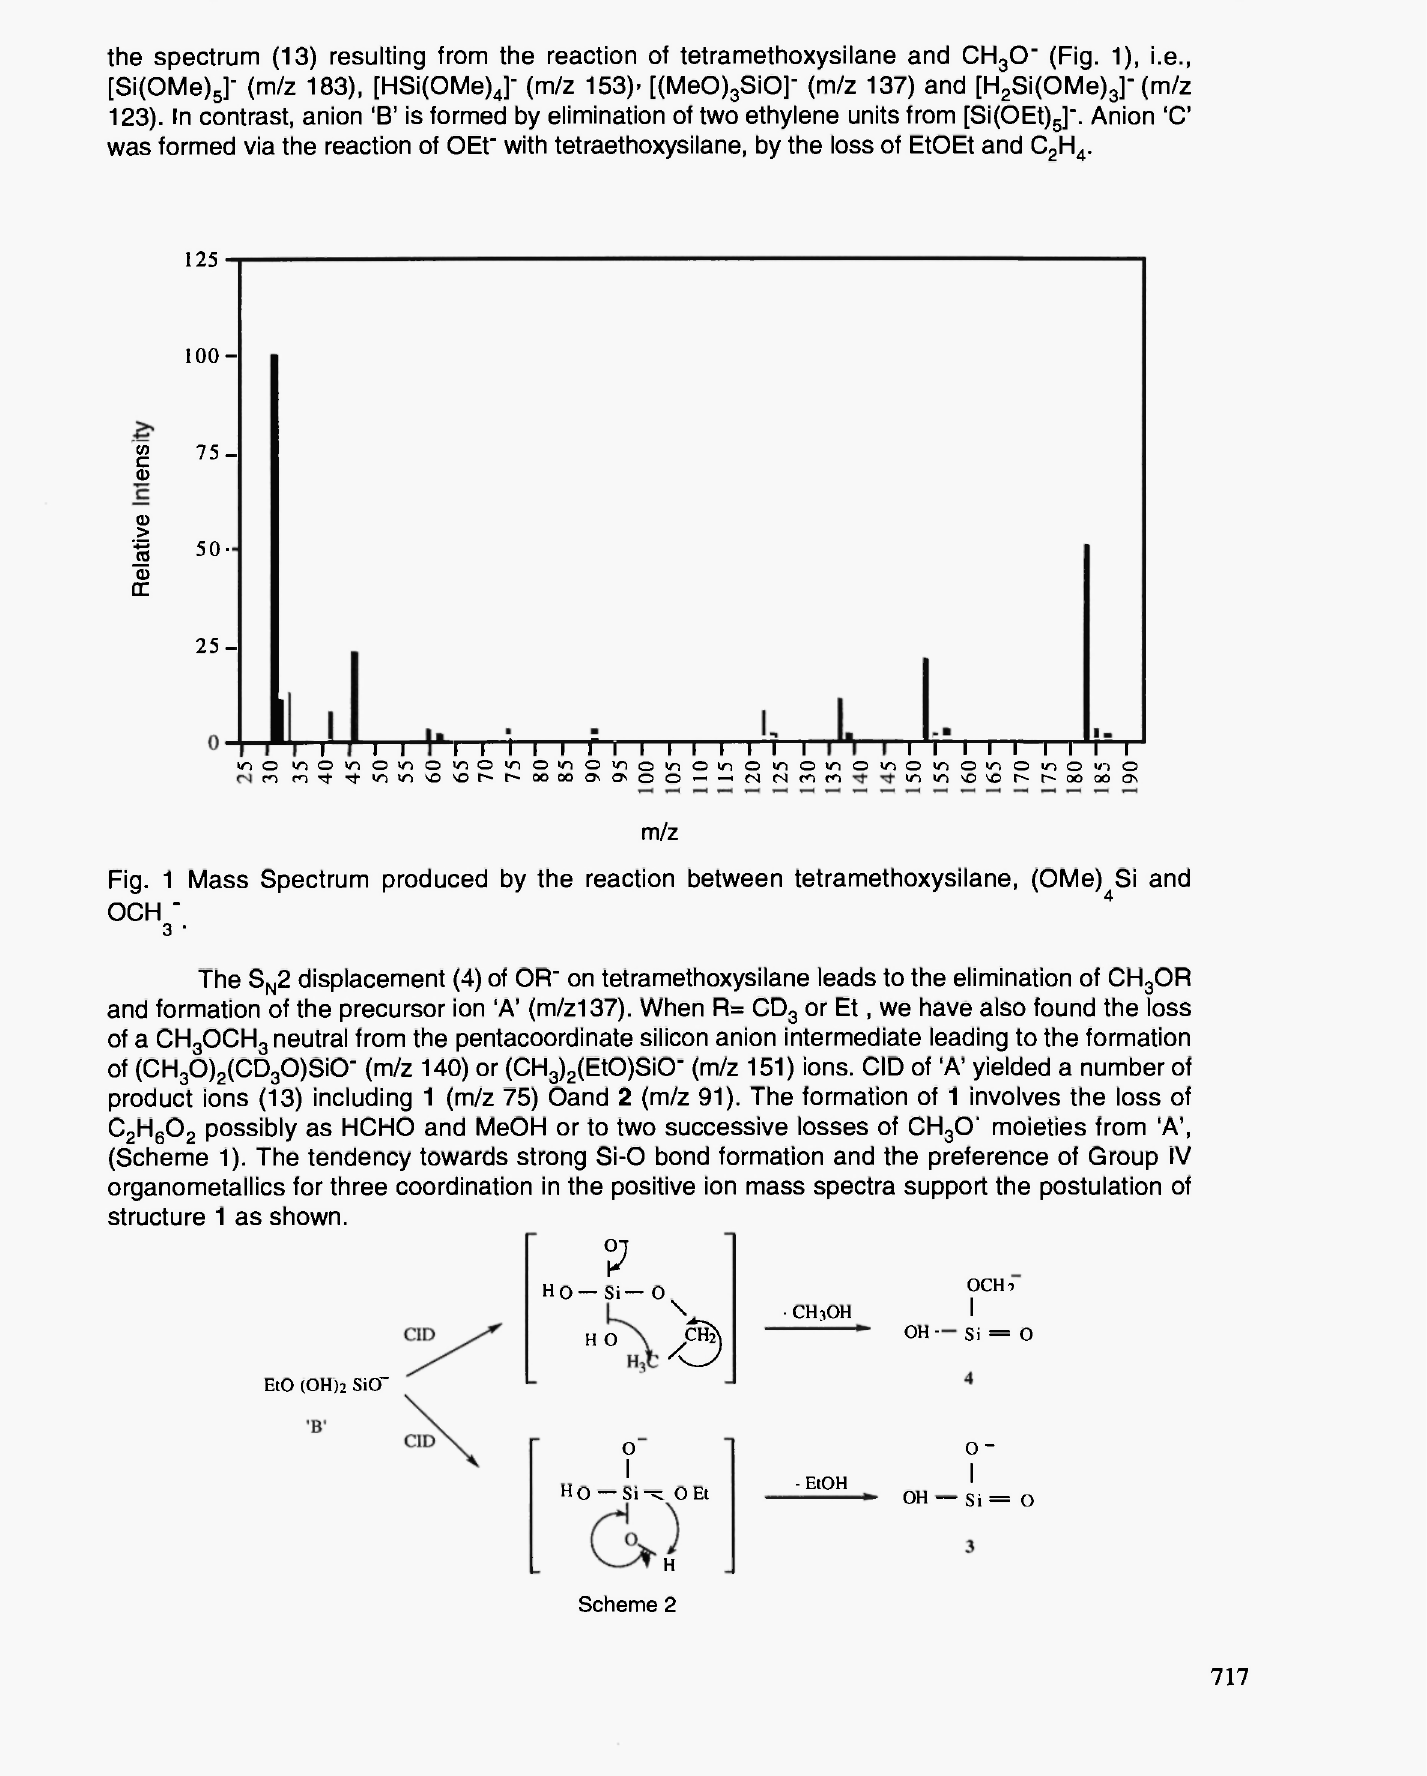
Fig. 1 Mass Spectrum produced by the reaction between tetramethoxysilane, (OMe) Si and OCH " 4 3 · The S N 2 displacement (4) of OR" on tetramethoxysilane leads to the elimination of CH 3 OR and formation of the precursor ion Ά' (m/z137). When R= CD 3 or Et, we have also found the loss of a CH 3 OCH 3 neutral from the pentacoordinate silicon anion intermediate leading to the formation of (CH 3 0) 2 (CD 3 0)Si0- (m/z 140) or (CH 3 ) 2 (EtO)SiO" (m/z 151) ions. CID of Ά' yielded a number of product ions (13) including 1 (m/z 75) Oand 2 (m/z 91). The formation of 1 involves the loss of C 2 H 6 0 2 possibly as HCHO and MeOH or to two successive losses of CH 3 0' moieties from Ά', (Scheme 1). The tendency towards strong Si-O bond formation and the preference of Group IV organometallics for three coordination in the positive ion mass spectra support the postulation of structure 1 as